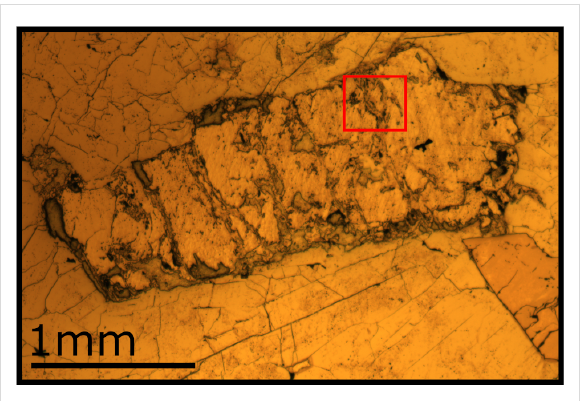
Figure 4: Reflected-light micrograph of the analysed Spodumene grain. The grain has relatively unaltered regions, separated by altered regions which intrude from the edge of the grain. Figure 5 was taken from within the region shown in red, across one such zone of altera-